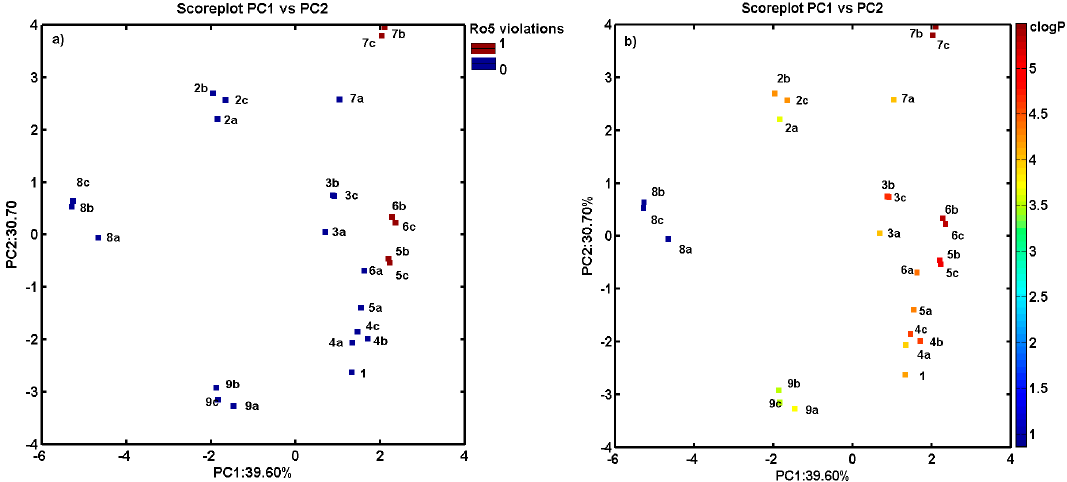
Figure 4. Projection of carbamates 1 – 9c on plane defined by first vs. second principal component with: number of Ro5 rule violations ( a ); and molecule lipophilicity profile ( b ). Colors code the number of Ro5 violations and value of calculated lipophilicity.